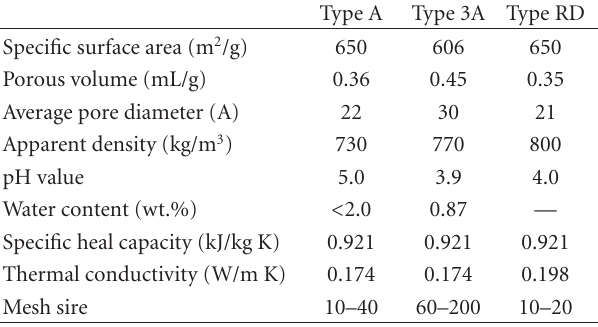
Table 2: Thermophysical properties of silica